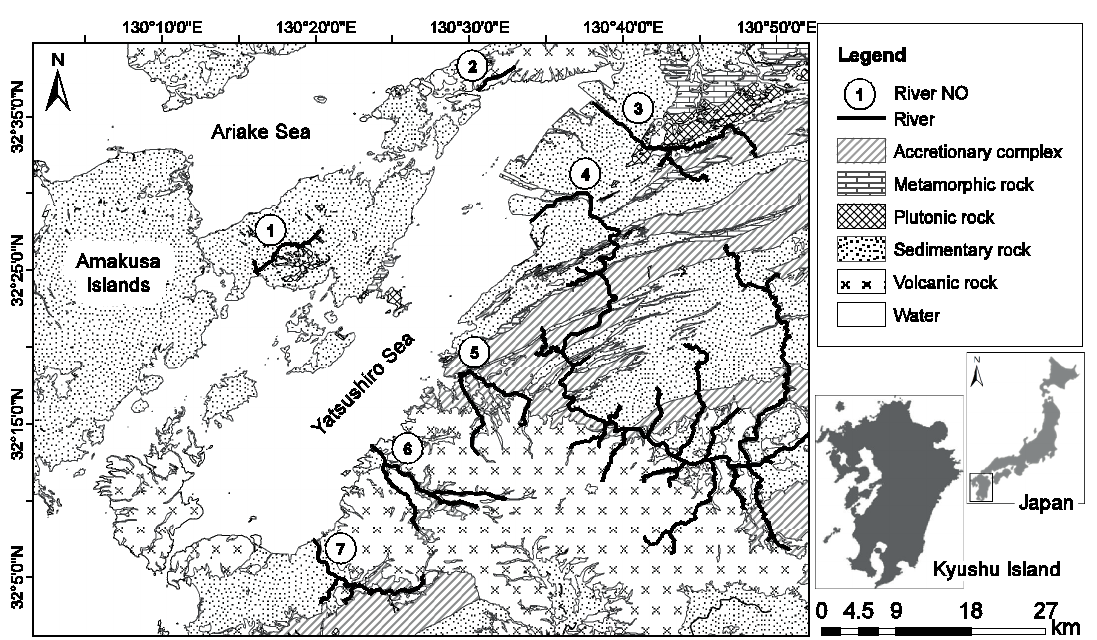
Fig. 1 The Yatsushiro Sea study area, Kyushu Island, south west Japan. Rivers NO are: ① Kawachi, ②